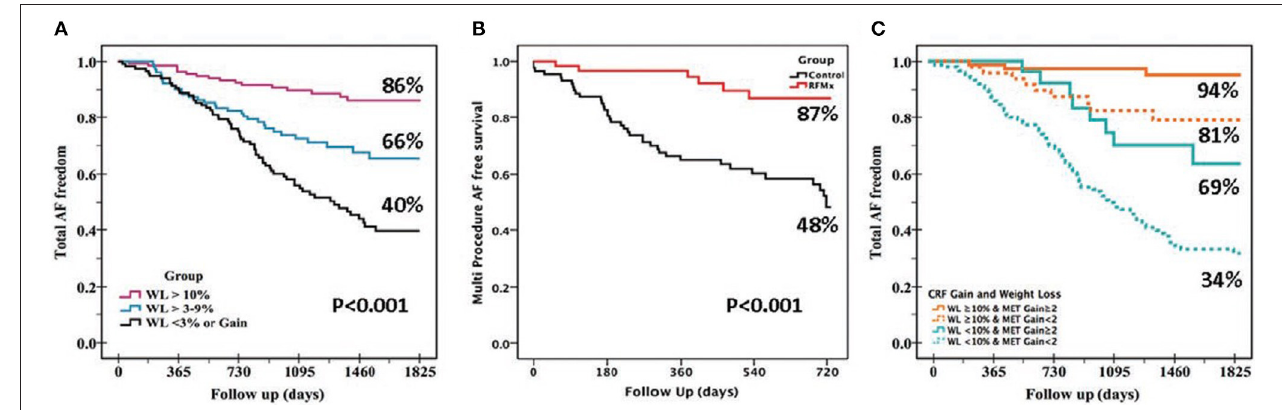
FIGURE 2 | Beneficial effects of various lifestyle modifications. The benefits of lifestyle and risk factor modifications on AF-free survival are evident from these Kaplan-Meier survival graphs: (A) Greater freedom from AF was seen with greater degree of weight loss (WL) in the LEGACY study. (B) Risk factor management (RFM) confers greater AF-free survival following catheter ablation procedure vs. usual care in the ARREST-AF Cohort Study. (C) Gain in cardiorespiratory fitness (MET, metabolic equivalent) confers independent and incremental AF free survival to WL in the CARDIO-FIT